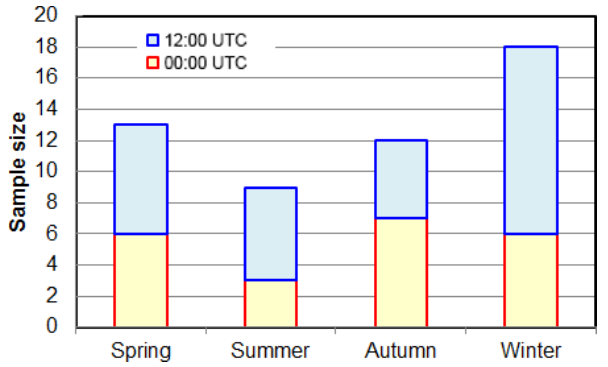
Figure 8. Number of samples for each season and for daytime and